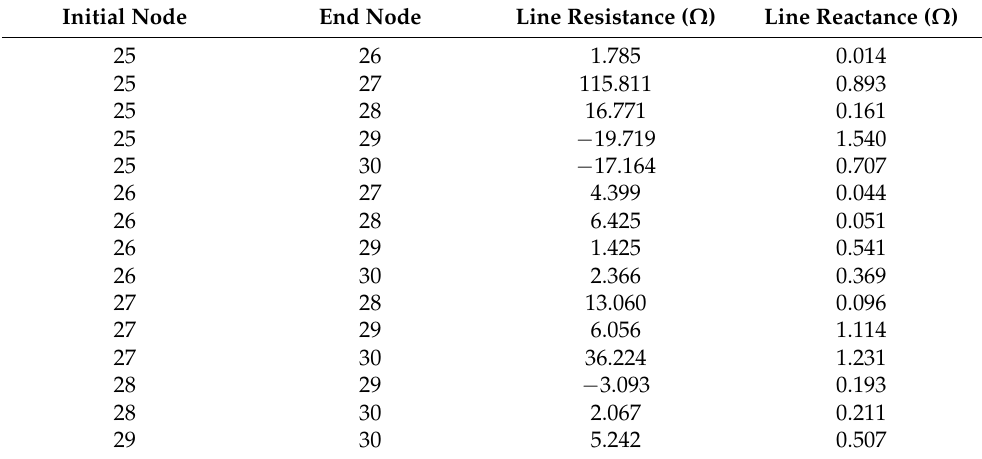
Table 4. Line impedance of the reduced IEEE 30-bus network only with generator nodes.